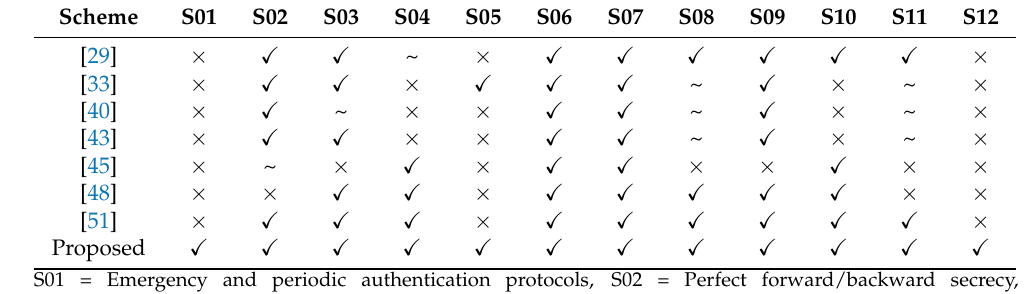
Figure 4. Authentication P-I. 3.4. Authentication P-II When the patient’s data must be obtained from the controller node and stored on the server at a specific time, the cloud-based medical server begins a periodic authentication with the controller node to ensure secure data transmission. Figure 5 demonstrates P-II, and as follows: 1. MS h generates secret numbers f h ∈ Z q *, b h ∈ Z q *, and current timestamp T 1 . MS h re- trieves ( CID i ) from the secure memory, where CID i = RE i ⊕ h ( S h ), (i.e., retrieve the identity of the requested P i ). MS h then computes XB h = b h * P , B h = b h * PK i , F h = h ( CID i )